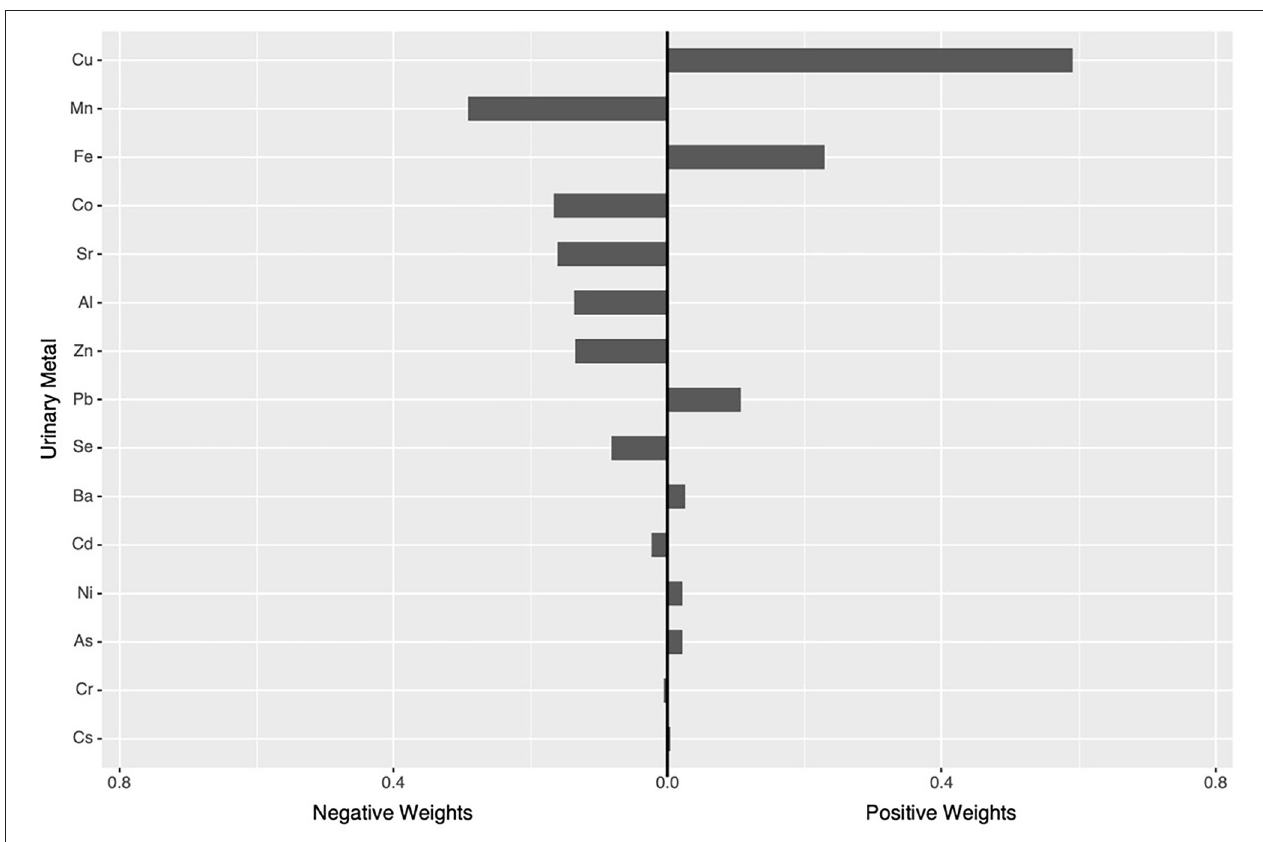
FIGURE 1 | qgcomp model a regression index weights for UACR. a The Model was adjusted for age, sex, BMI, education levels, smoking status, drinking status, hypertension and